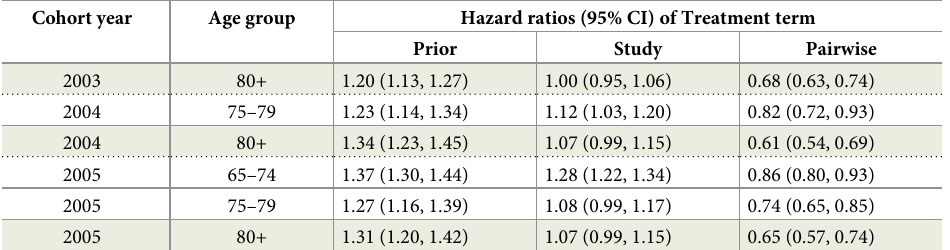
Table 2. Hazard ratios, adjusted for age and gender, presented for age-groups of the prior and study periods per- taining to each cohort, and their pairwise-adjusted estimates. Age groups, which were incrementally targeted for pneumococcal vaccination from 2003 to 2005, comprised adults aged over 79y; from 75 to 79y; and from 65 to